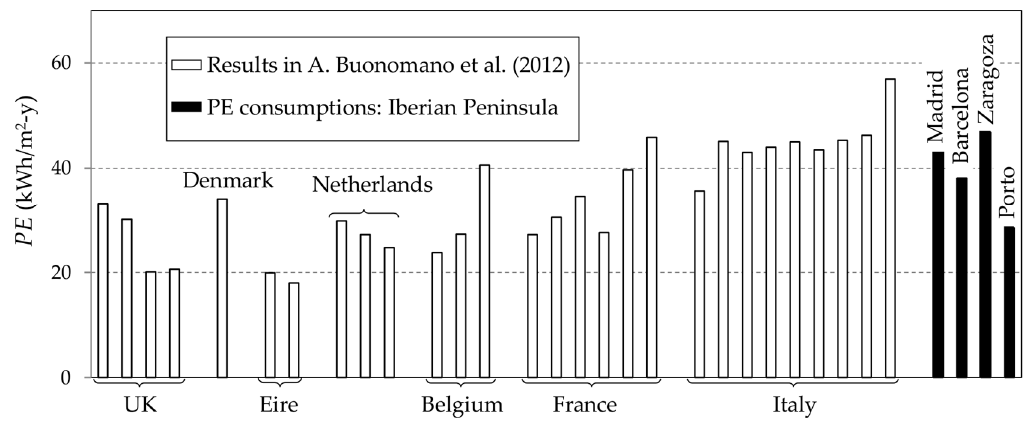
Figure 5. Annual primary energy consumption in Buonomano et al. [2], in comparison with annual primary energy consumption as calculated for the Iberian Peninsula cities. primary energy consumption as calculated for the Iberian Peninsula